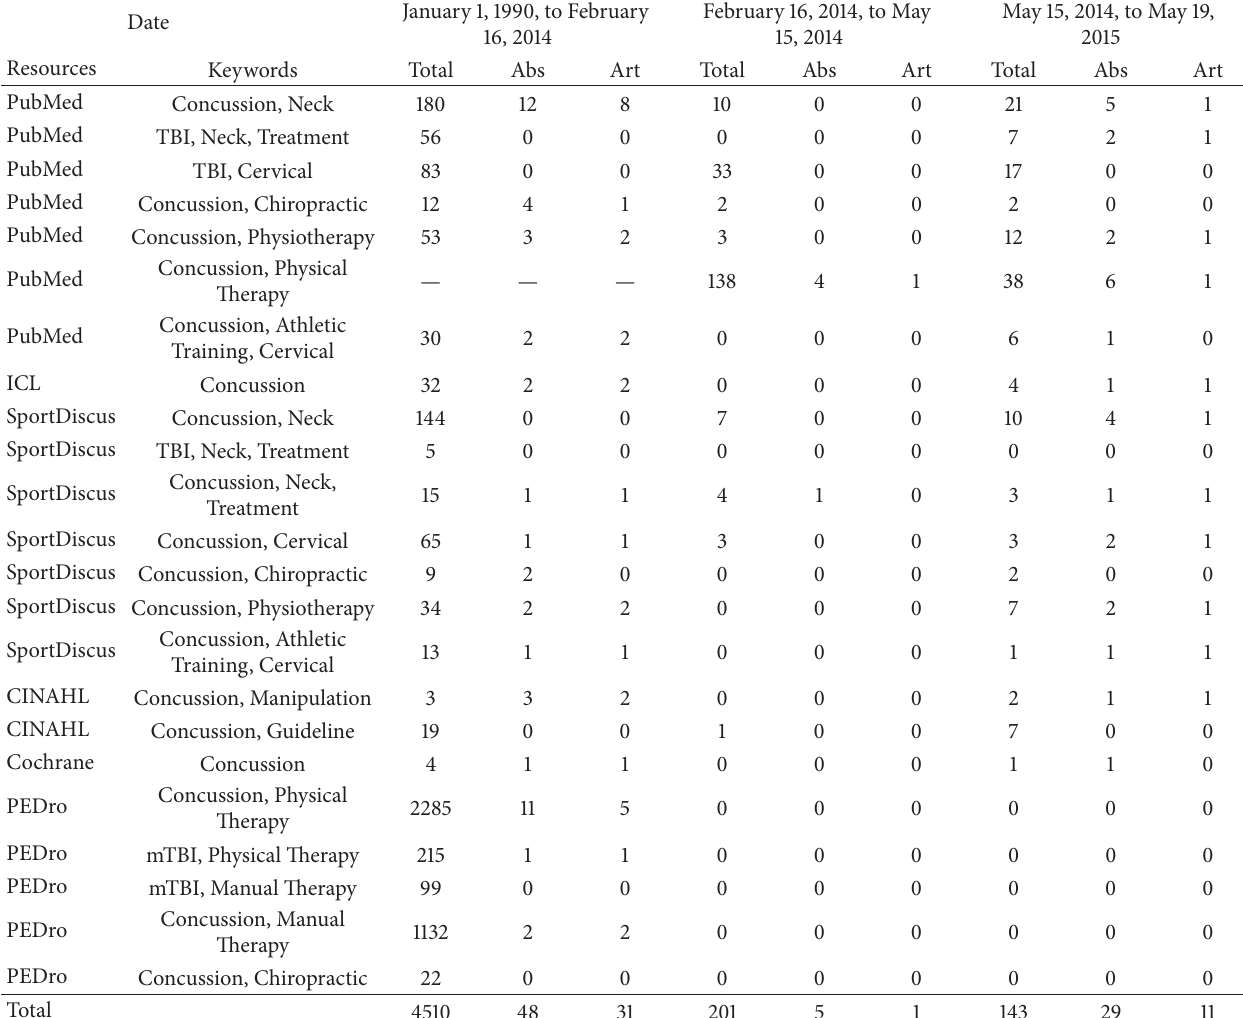
Table 1: Preliminary search of literature (total results/abstracts (Abs) selection/articles (Art) for